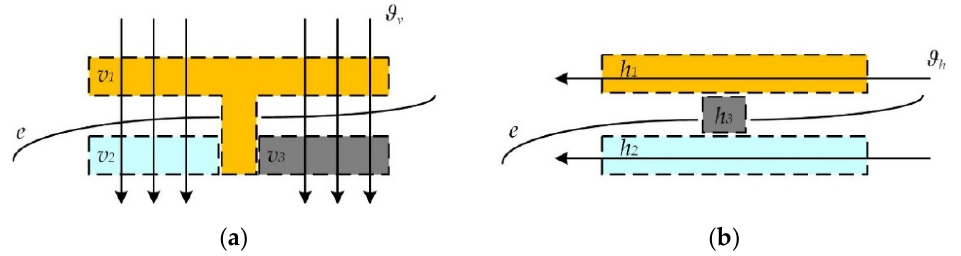
Figure 5. A set of orthogonal rays is used to resolve the segmentation at the edge break. ( a ) Ray scanning in the vertical direction cannot split two adjacent homogeneous regions at the fracture; ( b ) horizontal rays rescan the image to re-segment the initial homogeneous region at the fracture. By scanning the IR image in orthogonal directions (i.e., vertical ϑ v and horizontal ϑ h